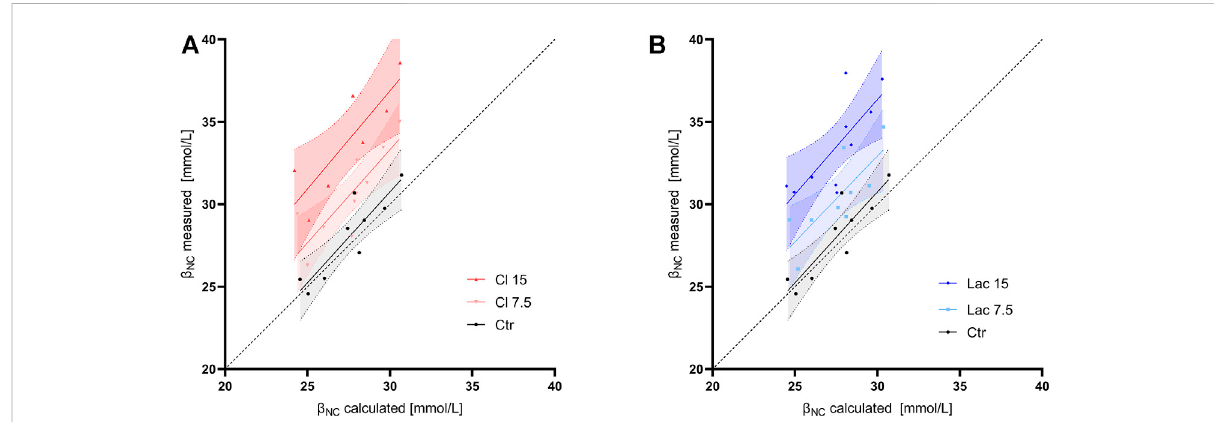
FIGURE 3 Noncarbonic buffer power calculated according to formula used in the Van Slyke equation ( β NC calculated) vs. the value measured using CO 2 tonometryatapHof7.2( β NC measured).Linearregressionlineandits95%con fi denceinterval areshownforeachgroupofaliquots. Thedashedline is the line of identity. (A) The control aliquot and aliquots with induced hyperchloremic acidosis. (B) The control aliquot and aliquots with induced lactic